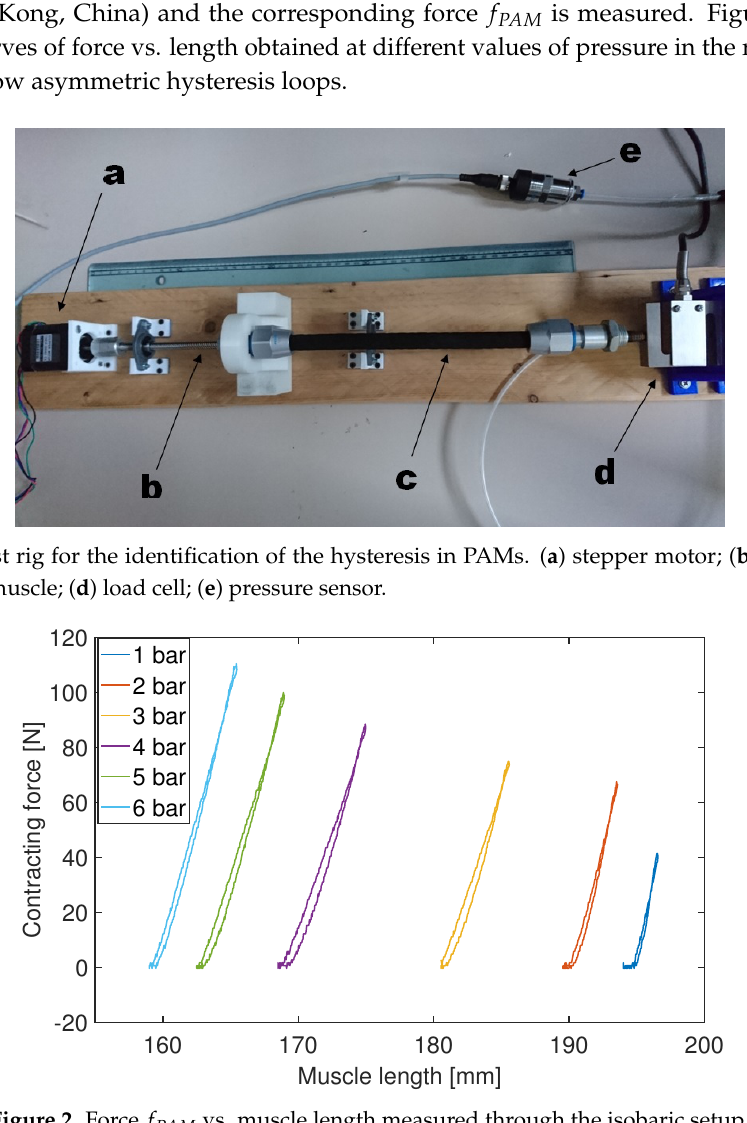
Figure 2. Force f PAM vs. muscle length measured through the isobaric